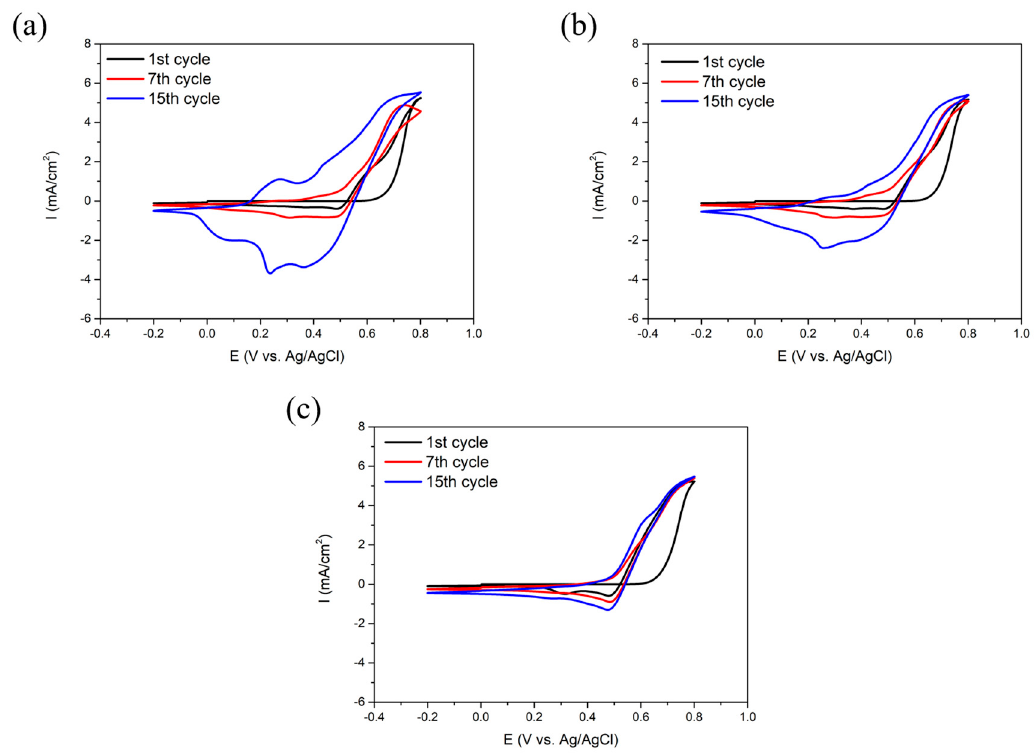
Figure 1. Cyclic voltammograms of SPAN deposited on an ITO electrode using electropolymerization in 1 M HCl with AN/DABSA mole ratio of ( a ) 10 (pH = − 0.17), ( b ) 8.8 (pH = − 0.19), and ( c ) 3.4 (pH = − 0.21) at a scan rate of 25 mV/s.